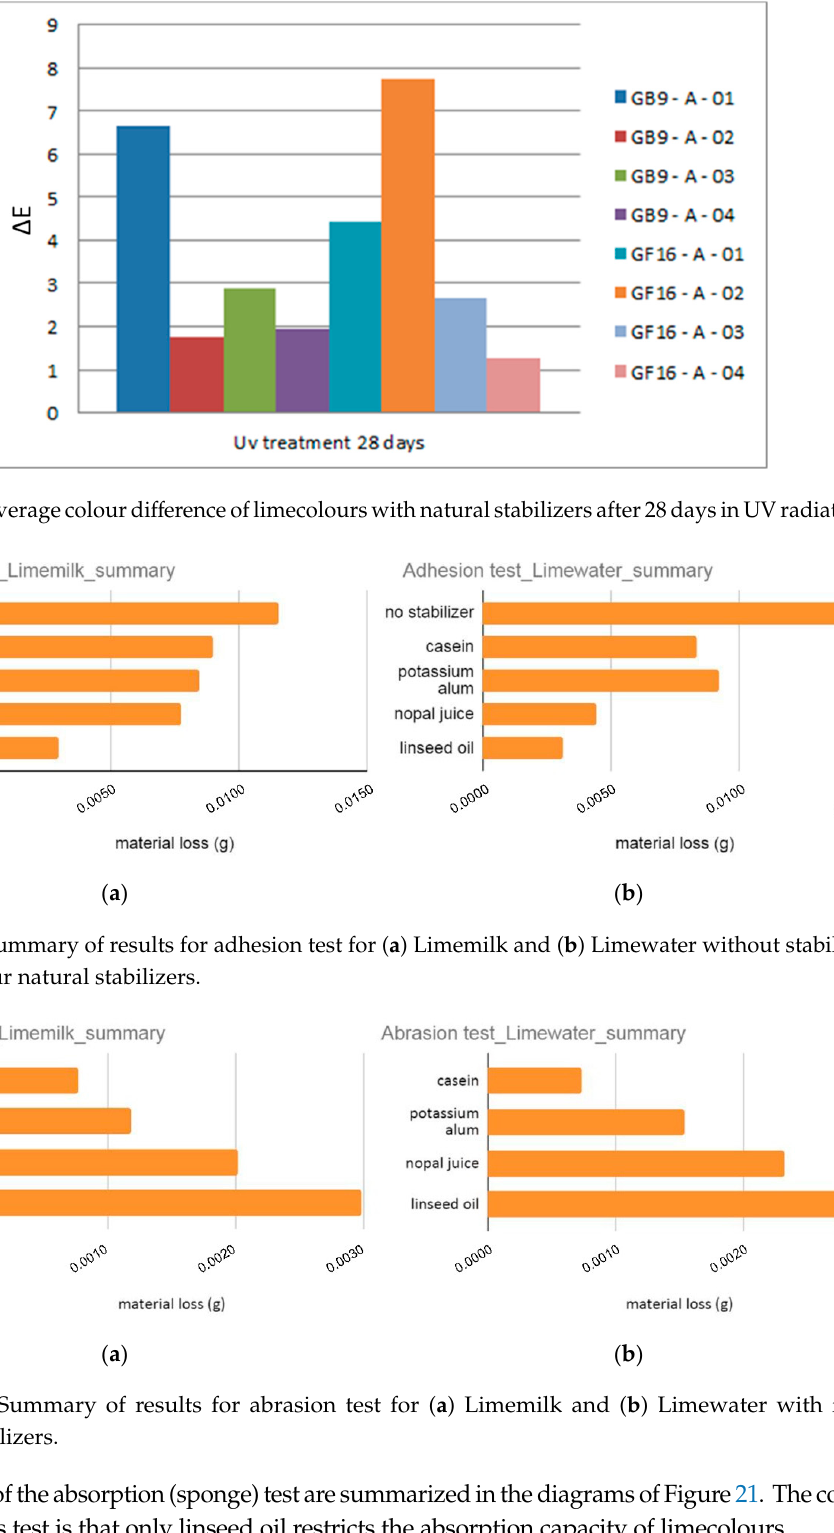
Figure 20. Summary of results for abrasion test based on the clay soil (granulometry < 2 mm). The results of the absorption (sponge) test are summarized in the diagrams of Figure 21. The conclusion derived from this test is that only linseed oil restricts the absorption capacity of limecolours.